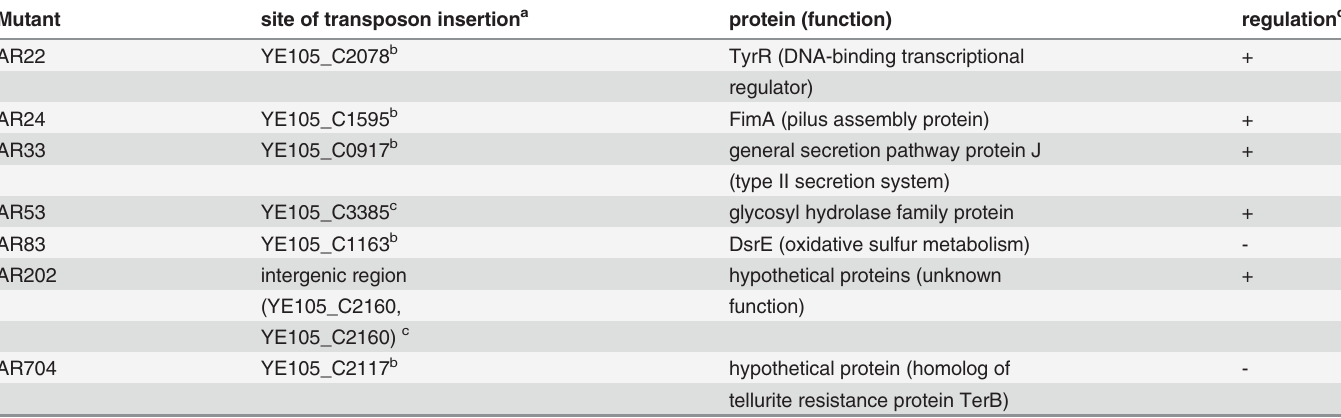
Table 1. Characterization of the sites of Tn5-B22 transposition in Y . enterocolitica mutants.